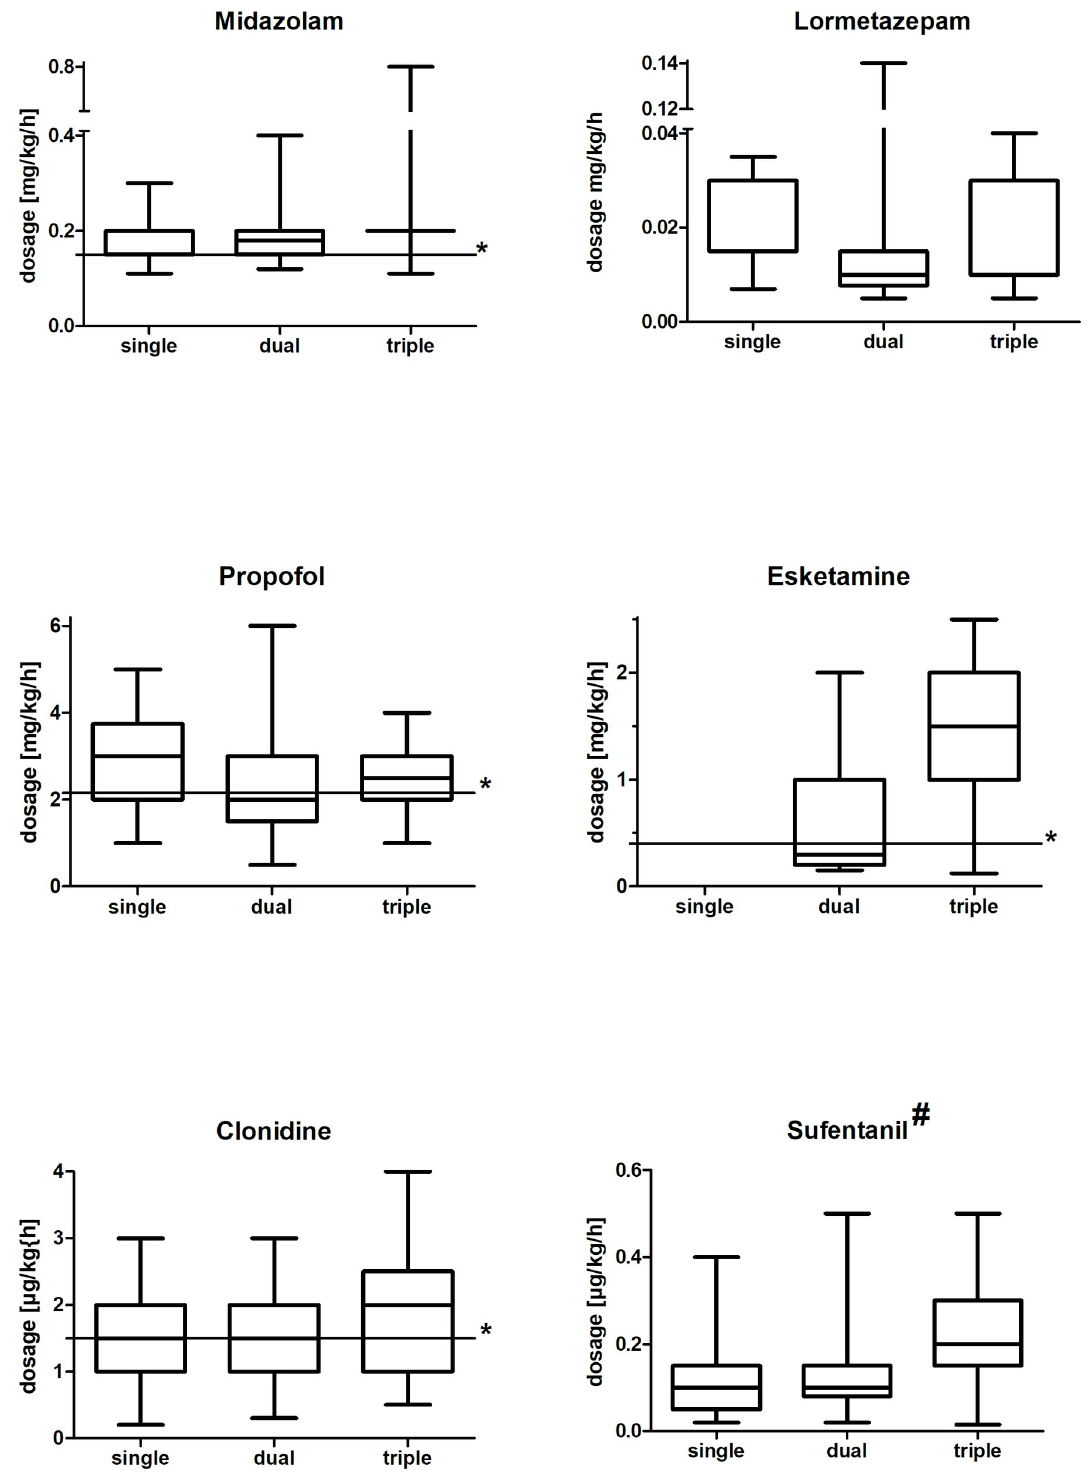
Fig 3. Pharmaceutical dosages administered. Administered pharmaceutical dosages in the time interval of the applied single, double or triple substance use. Data presented as box-whisker plots. # = Applied dosage of sufentanil as an opioid for analgesic therapy under prescribed sedation level. � = literature based median dosage. single = use of the corresponding substance as monosedativ, dual = application in combination with another sedative, triple = use in combination with two further sedatives, μ g = microgram, mg = milligram, kg = kilogram, h = hour, min =